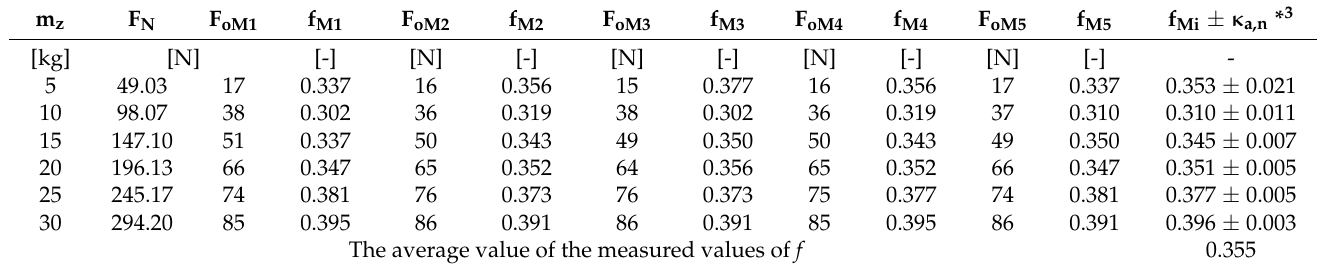
Table 6. Coefficient of friction, groove contaminated with oil, 8 mm diameter cable.